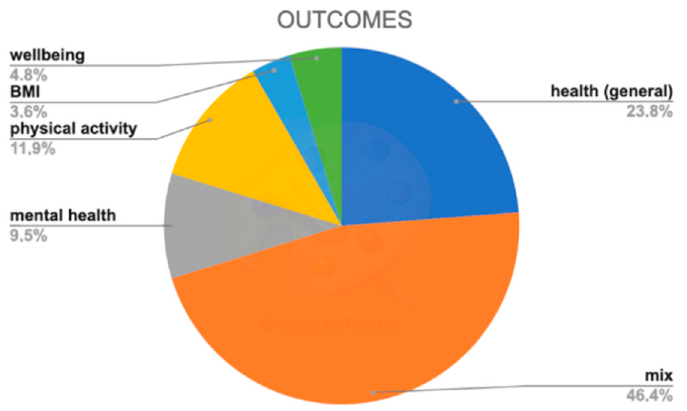
Figure 4. Different outcomes distribution grouped by main categories.